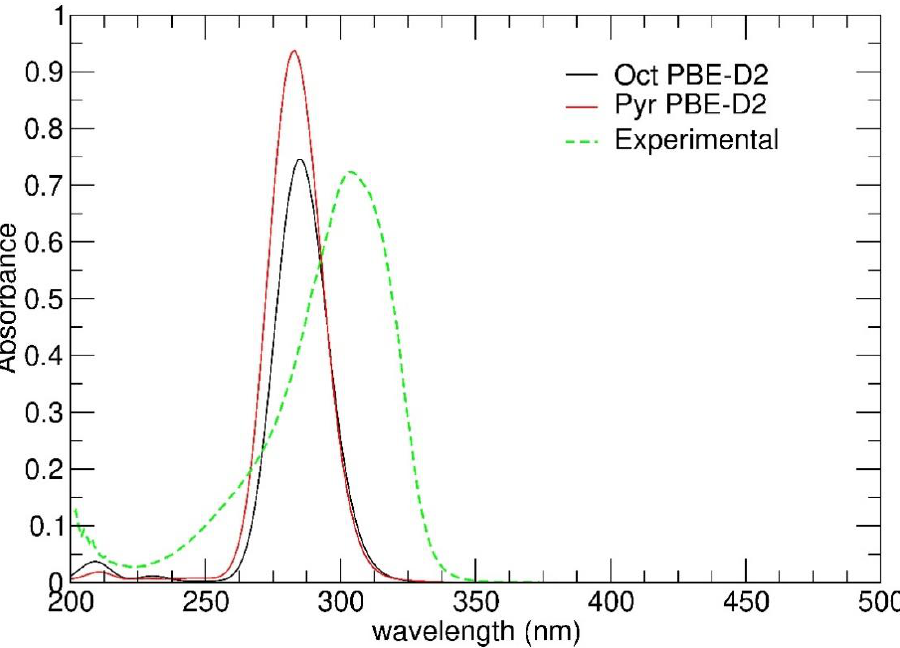
Figure 3. Simulated electronic spectra of the octahedral and pyramidal forms of Zn(hfa) 2 TMEDA along with the experimental spectrum obtained at room temperature in 1.25 × 10 −5 M ethanol solution.